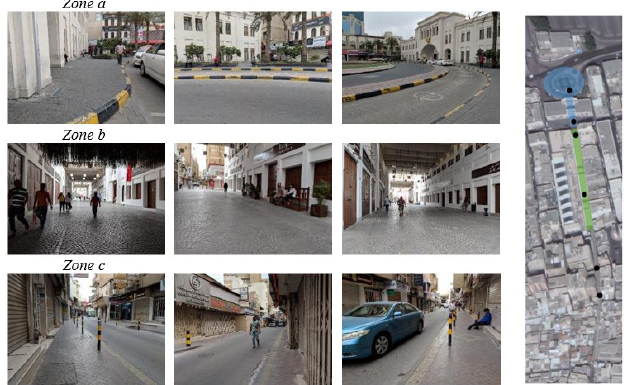
Figure 6. Using the physical landscape design elements (hardscape and softscape) in the 3 sections of Bab Al Bahrain Avenue